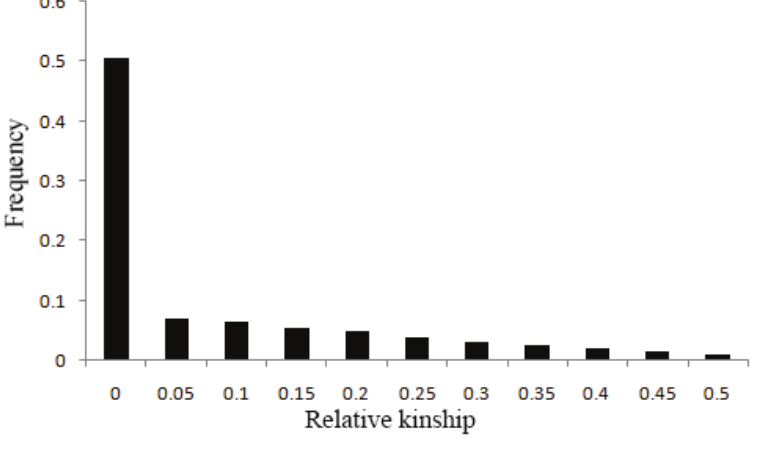
Figure 3. Distribution of relative kinship coefficient across the 520